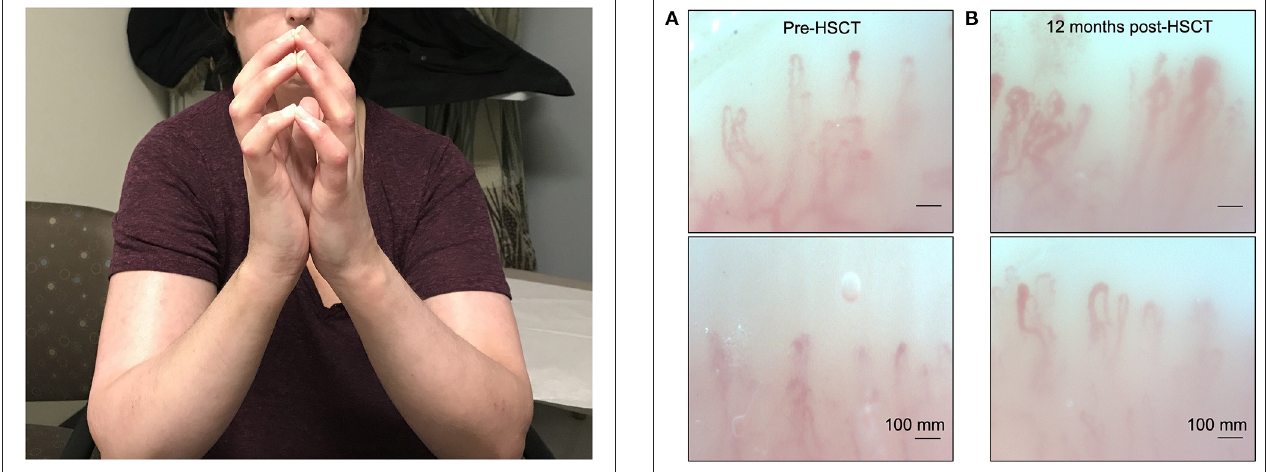
post-transplant, her mRSS has markedly improved